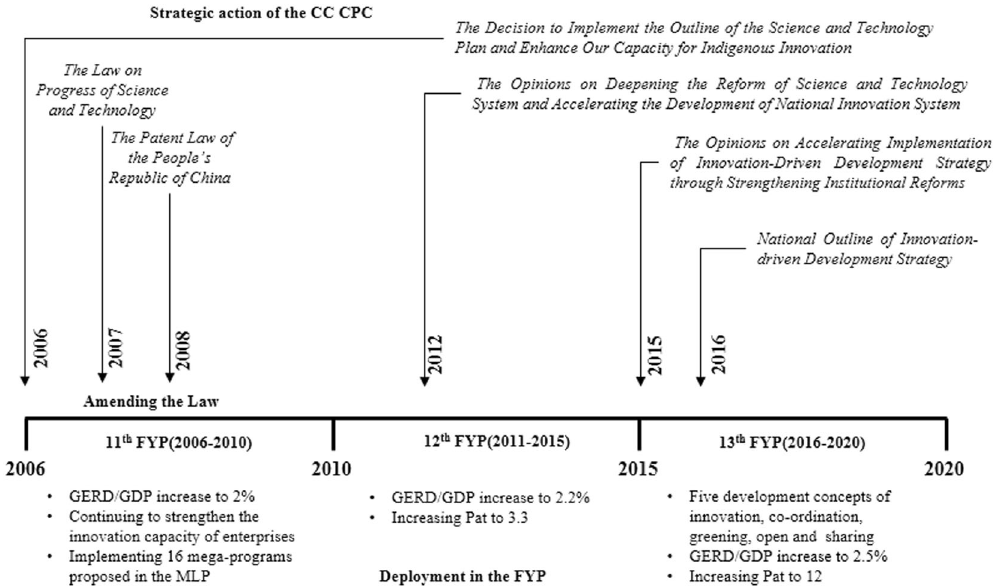
Fig. 1 Timeline of China ’ s strategic actions relating to the MLP. Pat - the number of invention patents granted per ten thousand Chinese citizens. Source: Authors ’